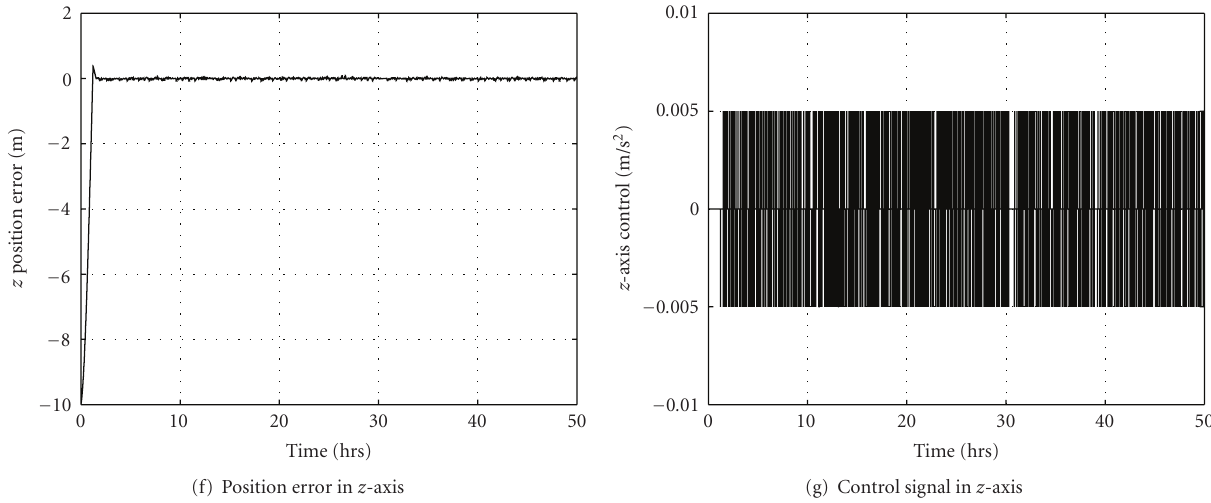
Figure 5: Simulation results using Fuzzy Logic control (control interval: 200 seconds; maximum firing time: 2 seconds).